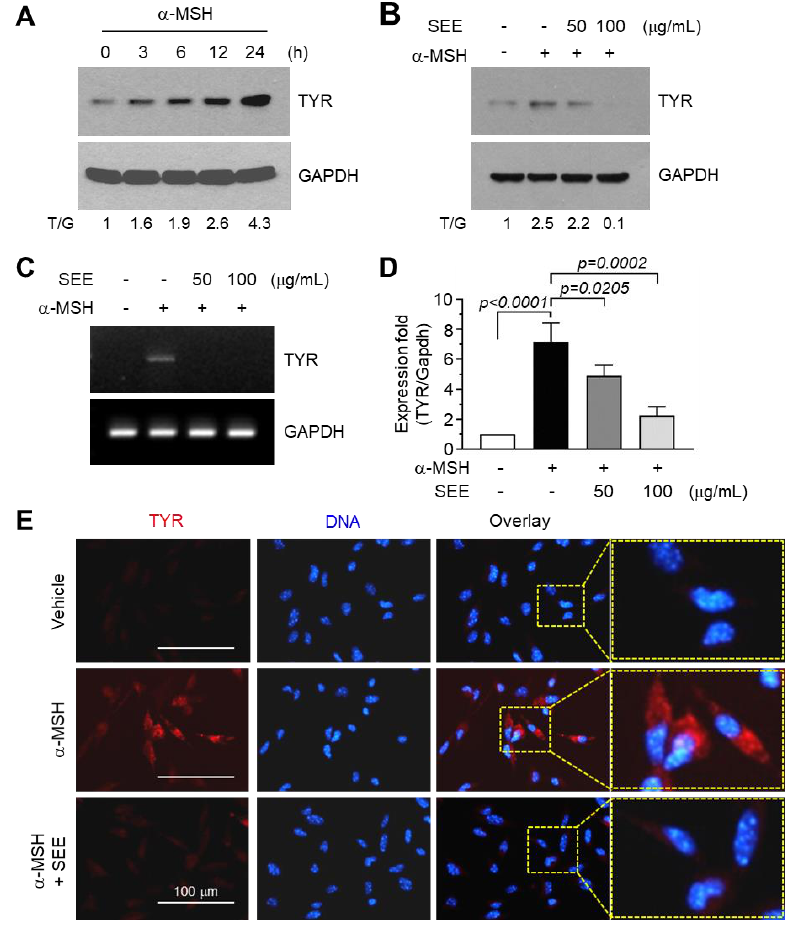
Figure 1. Effect of sorghum ethanolic extract (SEE) on the suppression of alpha-melanocyte-stimulating hormone ( α -MSH)-induced tyrosinase (TYR) expression. ( A ) B16F10 cells were treated with 100 nM α -MSH for various times (0–24 h) and cell lysates were subjected to immunoblotting using antibodies against TYR. The glyceraldehyde 3-phosphate dehydrogenase (GAPDH) level was examined as an internal control. T/G, tyrosinase/GAPDH ( B ) B16F10 cells were treated with either vehicle (DMSO) or SEE (50 and 100 µ g/mL) for 30 min, followed by stimulation with 100 nM α -MSH. After 12 h, cell lysates were prepared, and immunoblotting was performed using antibodies against TYR. The GAPDH level was examined as an internal control. The intensity of the bands was quantified using ImageJ and the relative TYR intensity was normalized to that of GAPDH and visualized in the blot. T/G, TYR/GAPDH. ( C , D ) B16F10 cells were treated with either vehicle (DMSO) or SEE (50 and 100 µ g/mL) for 30 min, followed by stimulation with 100 nM α -MSH. After 6 h, total RNA was isolated and TYR mRNA was measured by RT-PCR ( C ) and quantitative real-time PCR ( D ). The GAPDH mRNA level was examined as an internal control. ( E ) B16F10 cells were treated with vehicle (DMSO) or SEE (50 µ g/mL) in the absence or presence of 100 nM α -MSH. After 12 h, the cells were fixed and incubated with antibodies against TYR for 2 h, followed by incubation with Alexa Fluor 555-conjugated (red signal) secondary antibodies for 30 min. Nuclear DNA was stained with 1 µ g/mL Hoechst 33258 for 10 min (blue signal). The dotted box indicates the region of higher magnification in